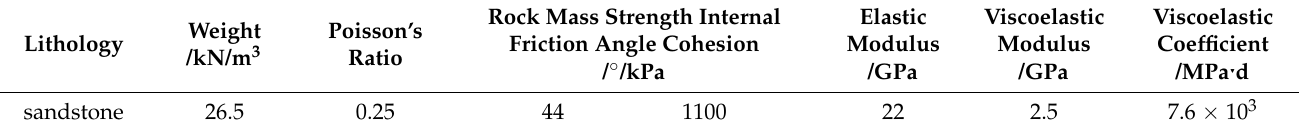
Table 1. The rock foundation calculated